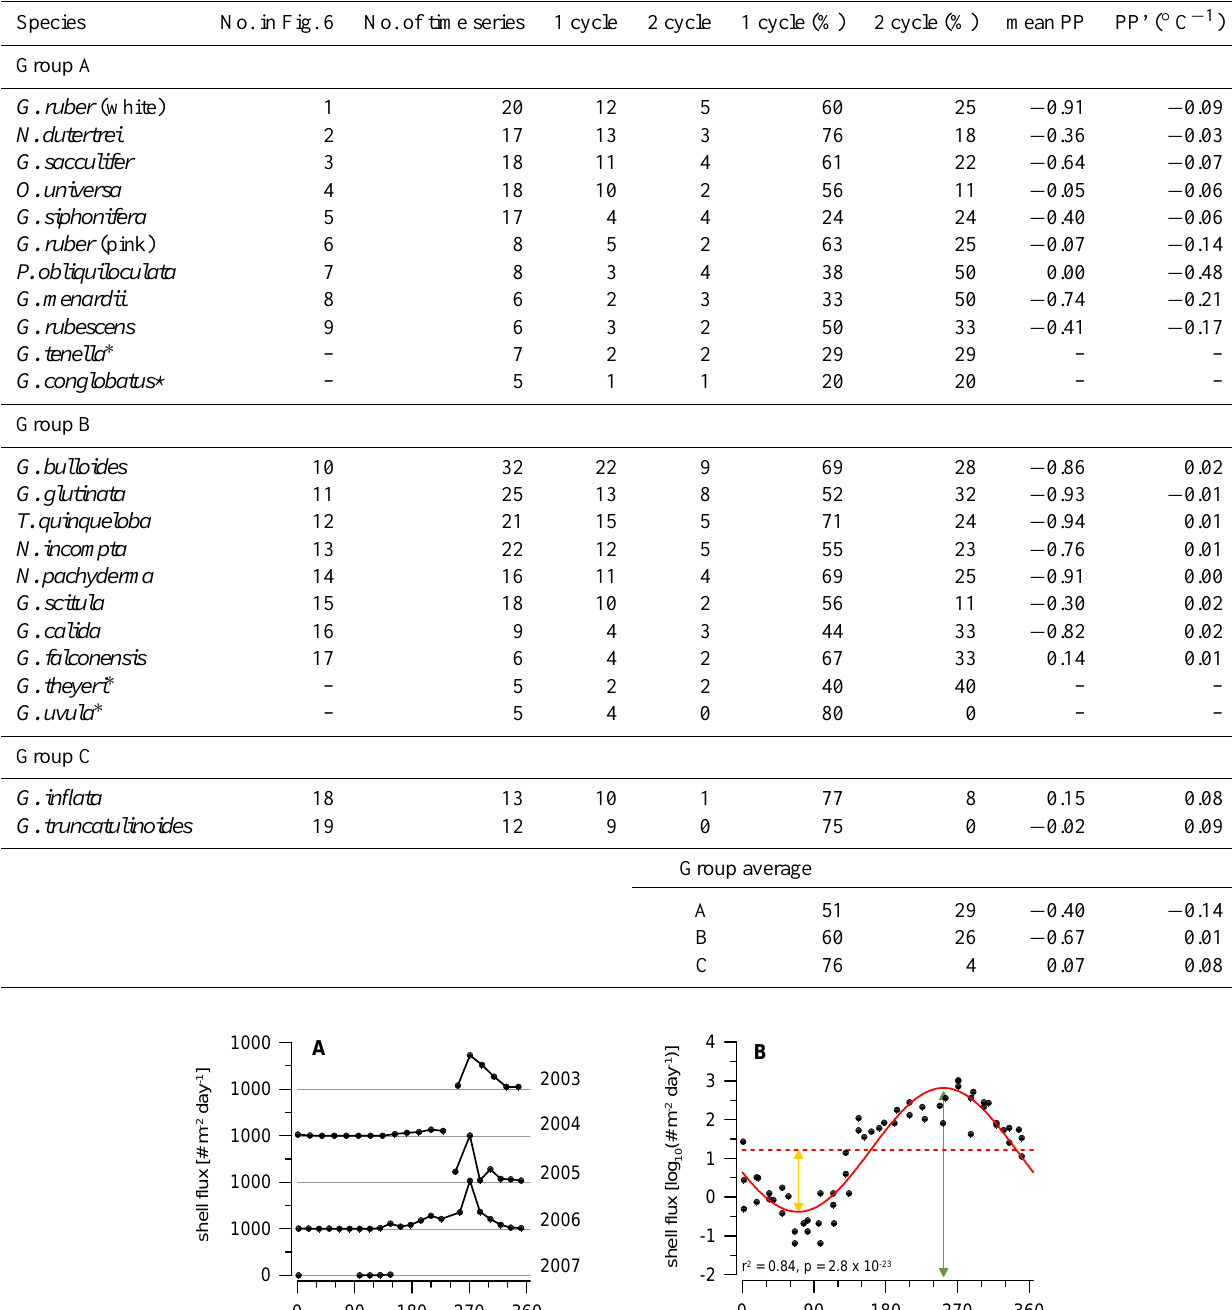
Table 2. Results from periodic regression. Species marked with an ∗ have fewer than five observations with significant cyclicity and are excluded from the analysis.